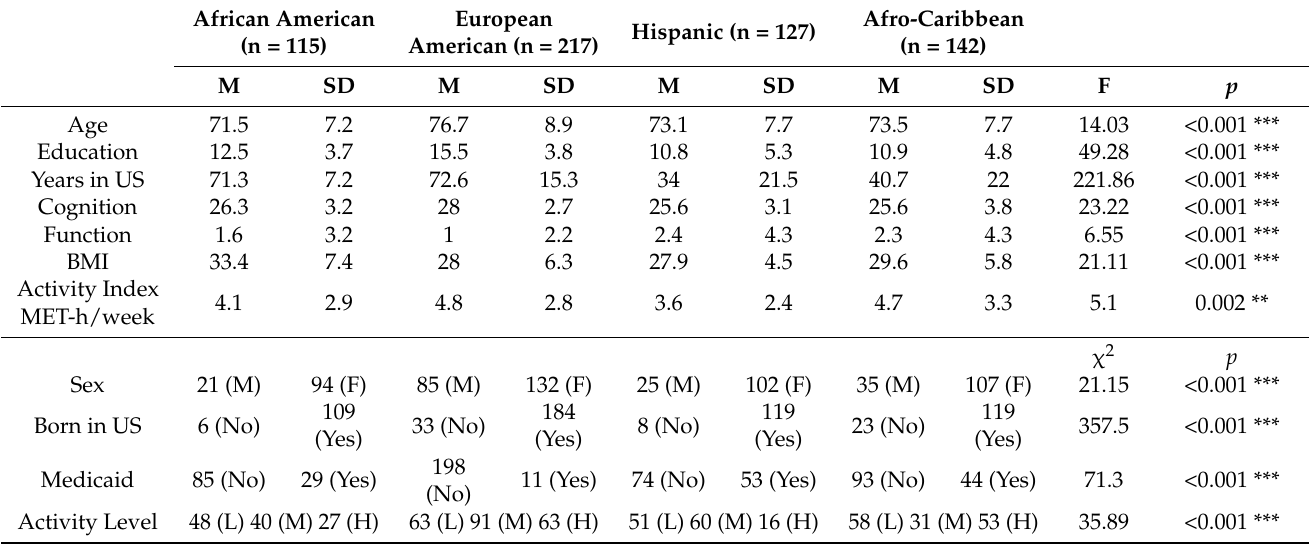
Table 2. Sample Characteristics by Ethnic Group (n = 601).